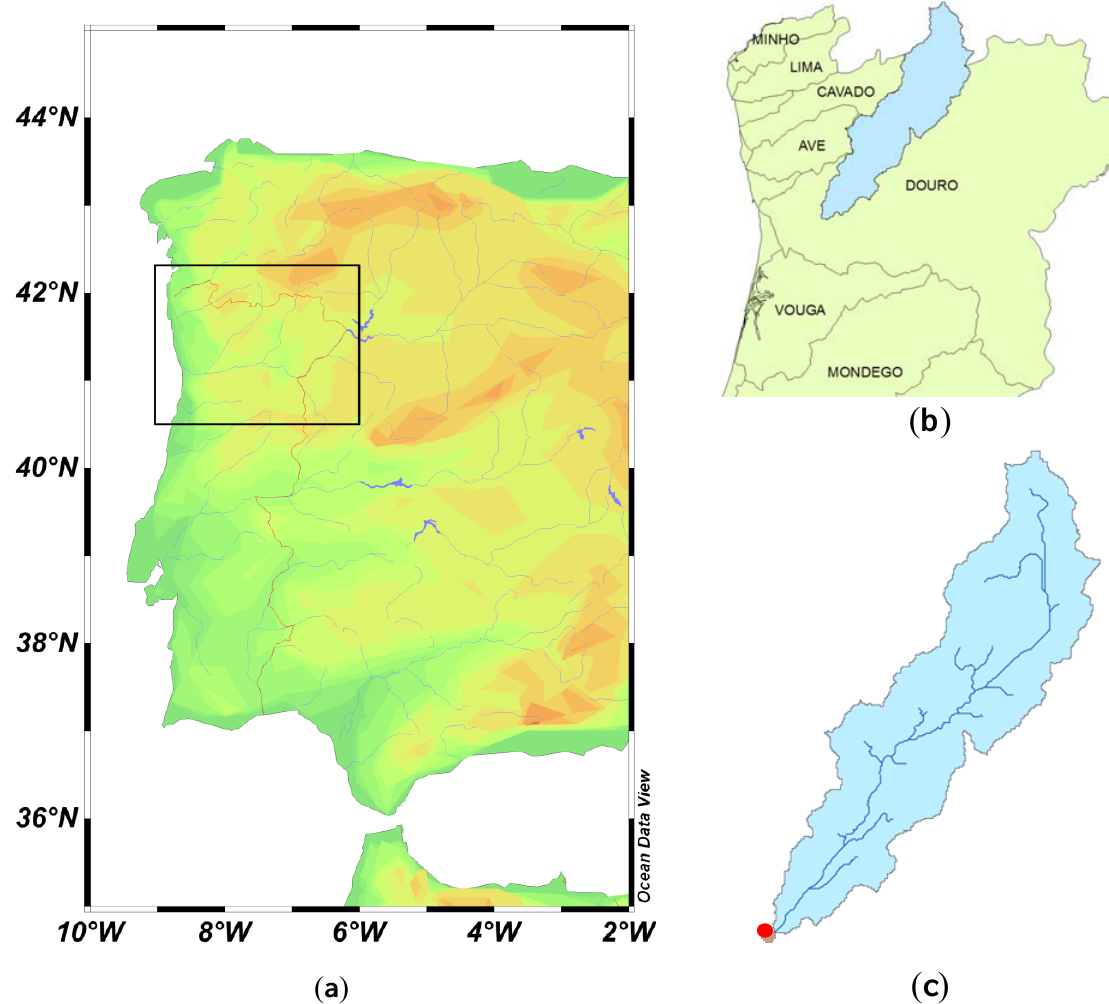
Figure 1. The study area: The black box in the map of Iberia ( a ) outlines the north of Portugal ( b ) where the Torrão drainage basin is located (in blue). ( c ) Caption of the drainage network in the watershed, and location of the reservoir (red